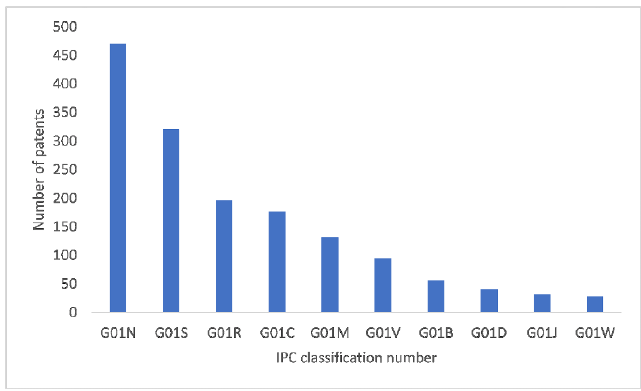
Fig. 8 IPC distribution in